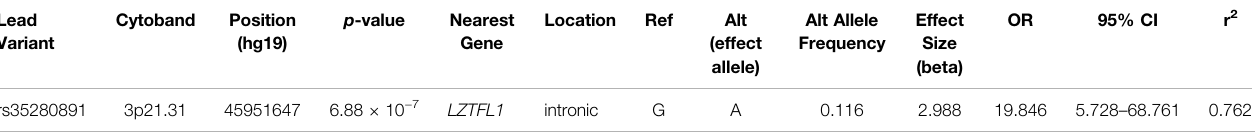
TABLE 3 | Lead variants: severe versus mild COVID-19. Lead Variant